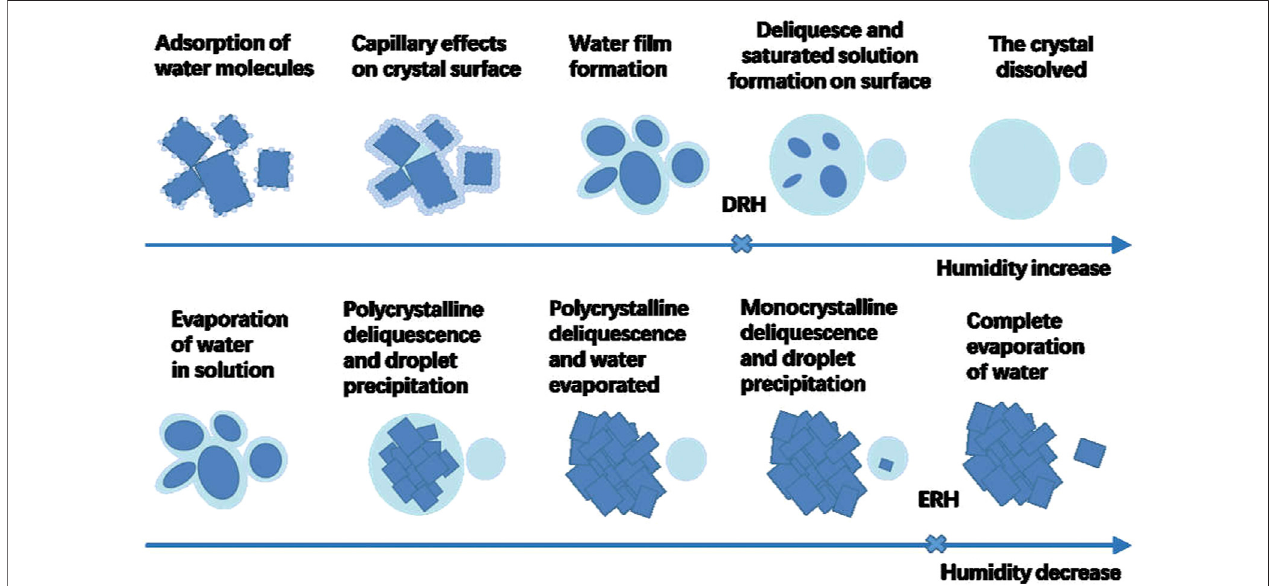
FIGURE 12 | The deliquescence and ef fl orescence under relative humidity change (Xu et al., 2020).